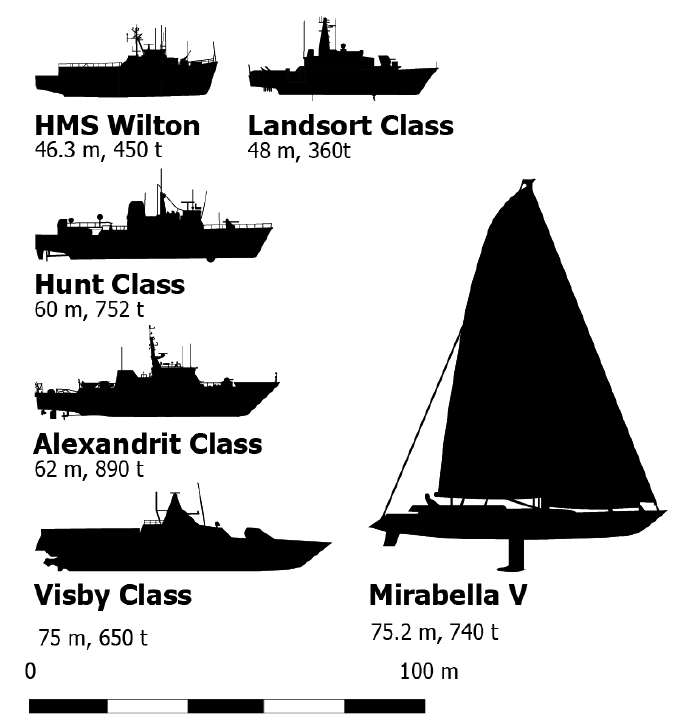
Figure 2. Representative composite ships and yachts drawn to scale.